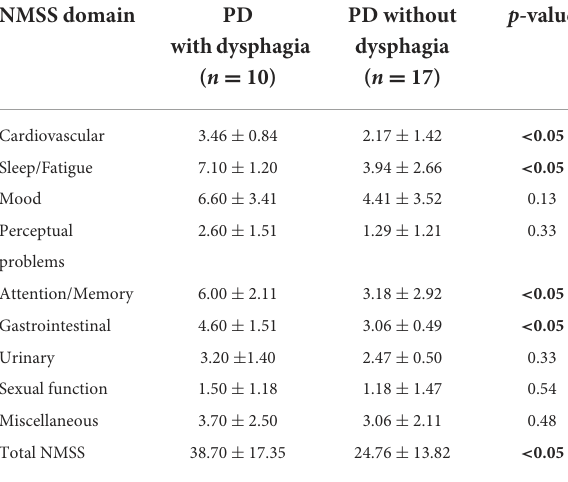
TABLE 2 Comparison of NMSS-K score between PD with dysphagia and PD without dysphagia group.